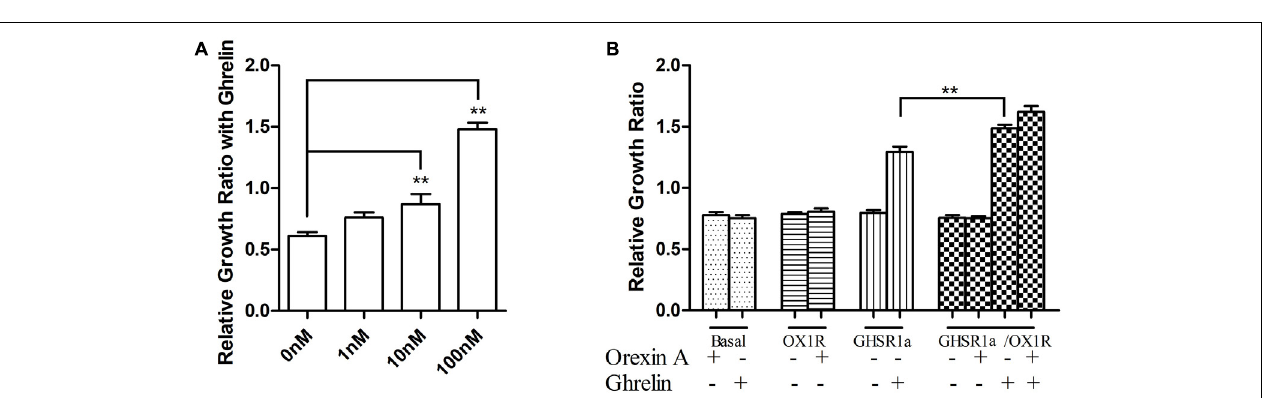
FIGURE 9 | Proliferation of stable cell groups in response to ghrelin. (A) Dose-dependent effects of ghrelin on stable SH-SY5Y-GHSR1a/OX1R cell proliferation. Cell proliferation was measured using a CCK-8 proliferation/viability assay. Stable cells that were not stimulated with ghrelin were used as the control. ∗∗ p < 0.01, cells co-expressing both GHSR1a/OX1R and treated ghrelin vs. control. (B) The stable SH-SY5Y-GHSR1a, SH-SY5Y-OX1R, and SH-SY5Y-GHSR1a/OX1R cells or SH-SY5Y cells were cultured in a 96-well plate and starved overnight in serum-free medium. Then, cells were stimulated with 100 nM ghrelin or 100 nM orexin-A